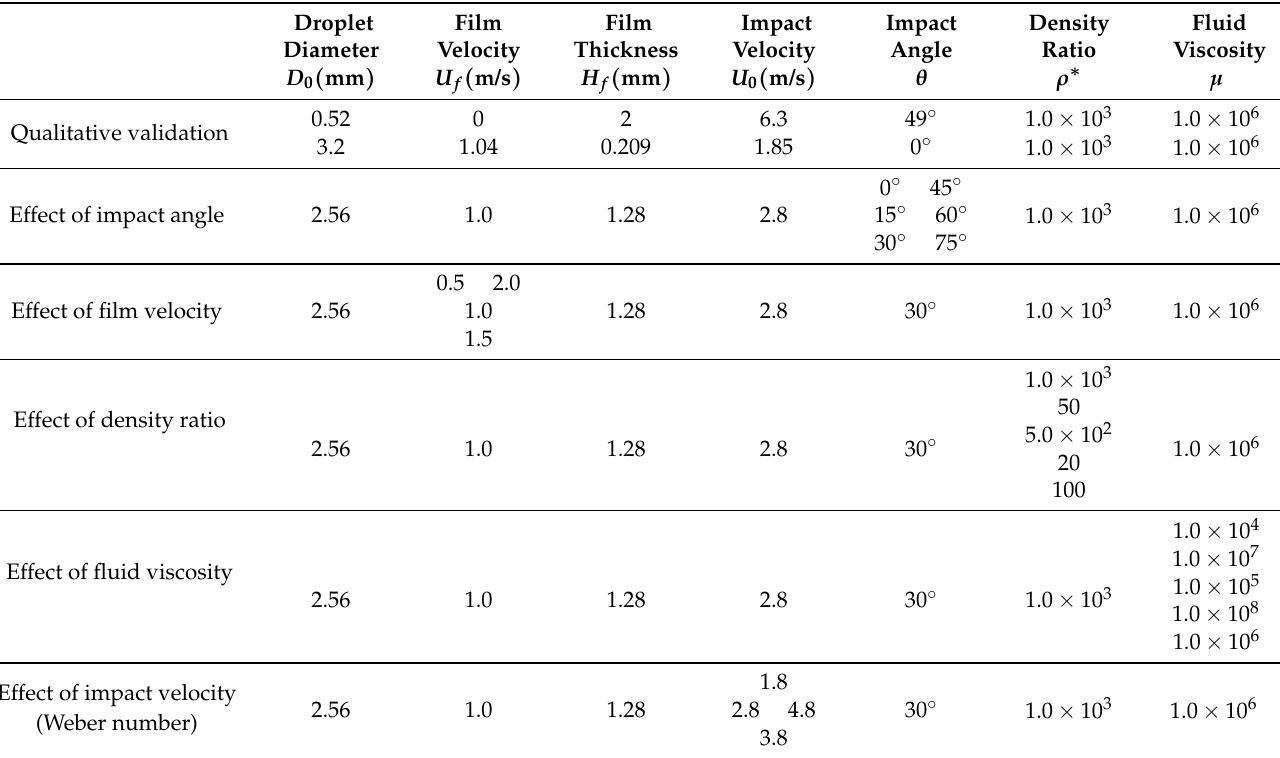
Table 1. Critical parameters of numerical for each of case.